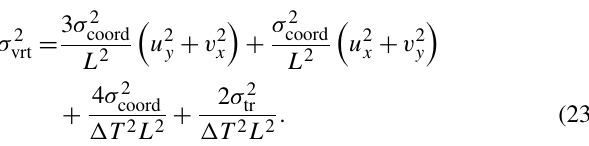
Figure 3. Uncertainty of divergence and vorticity for a square in a spatially varying velocity field with gradients u x , u y , v x , v y